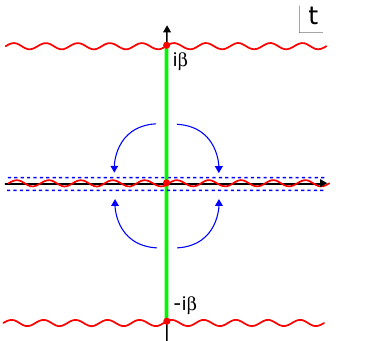
i(cid:15) (blue lines). Right: relevant (cid:6)